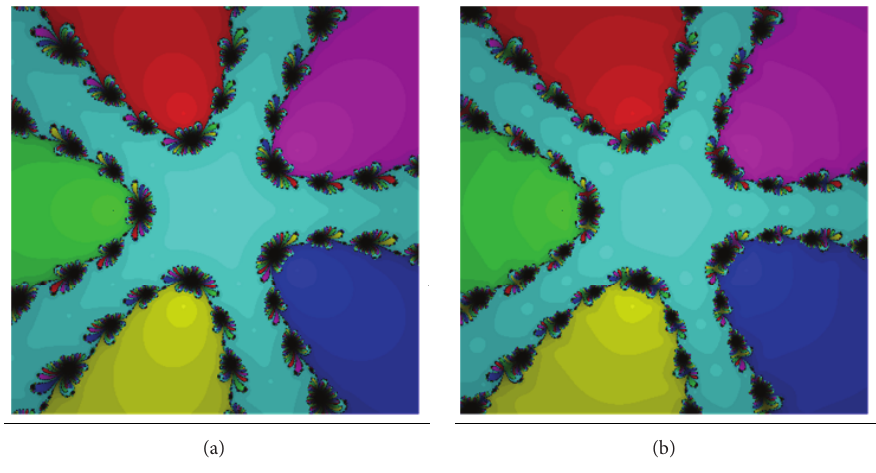
Figure 6: The methods (6) (a) and (14) (b) for Test Problem